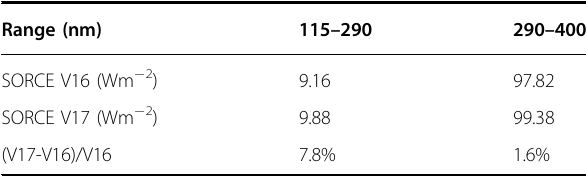
Table 4 Comparison of the SORCE V16 with V17 power in two speci fi c wavelength domains